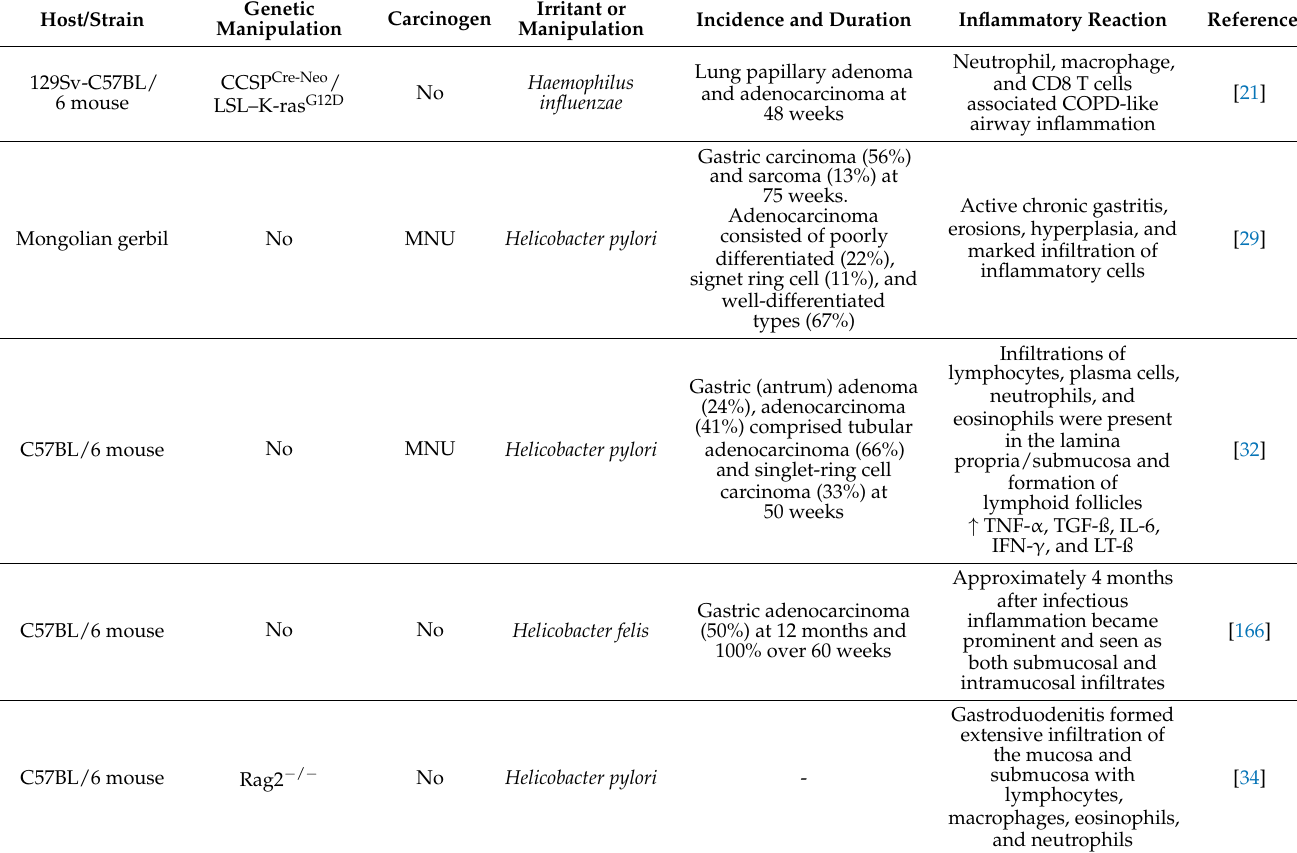
Table 4. Infection-induced inflammation-related carcinogenesis